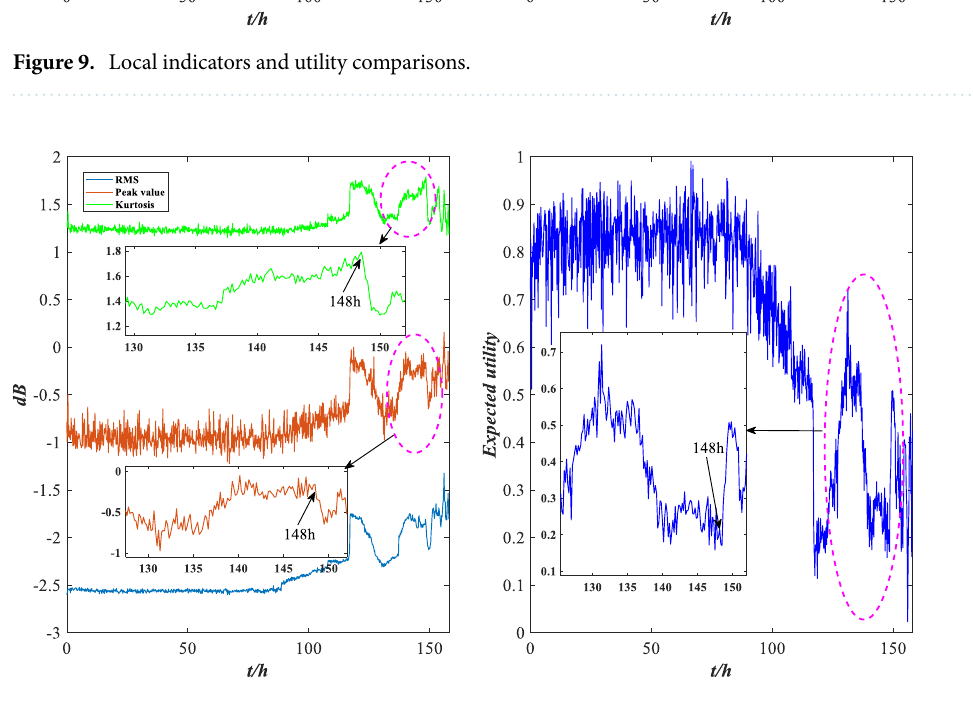
Figure 10. Local indicators and utility